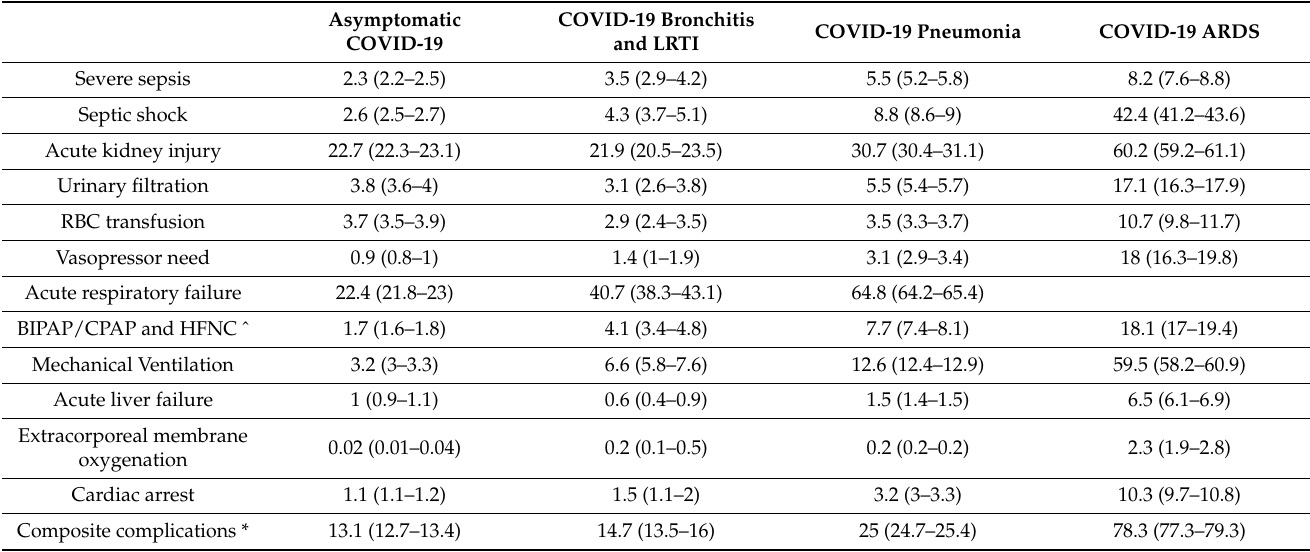
Table 3. The proportion of Complications in